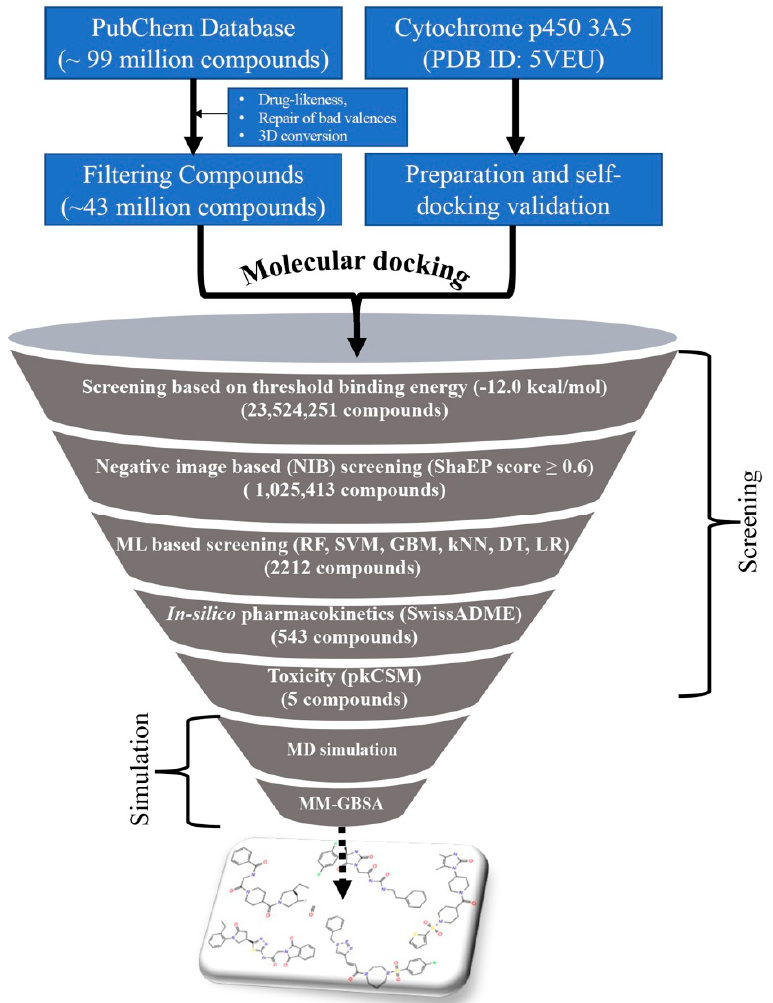
Figure 1. The workflow of screening the PubChem database against